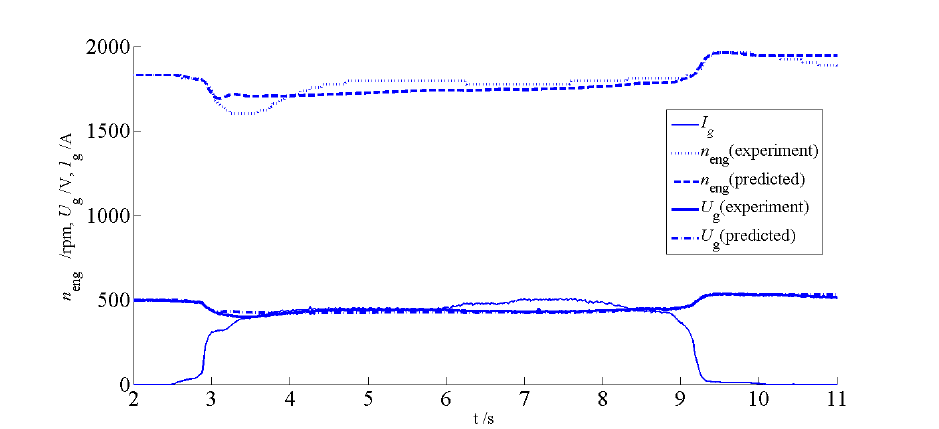
Figure 4. Simulation vs. experiment results of the voltage and speed history during the dynamic